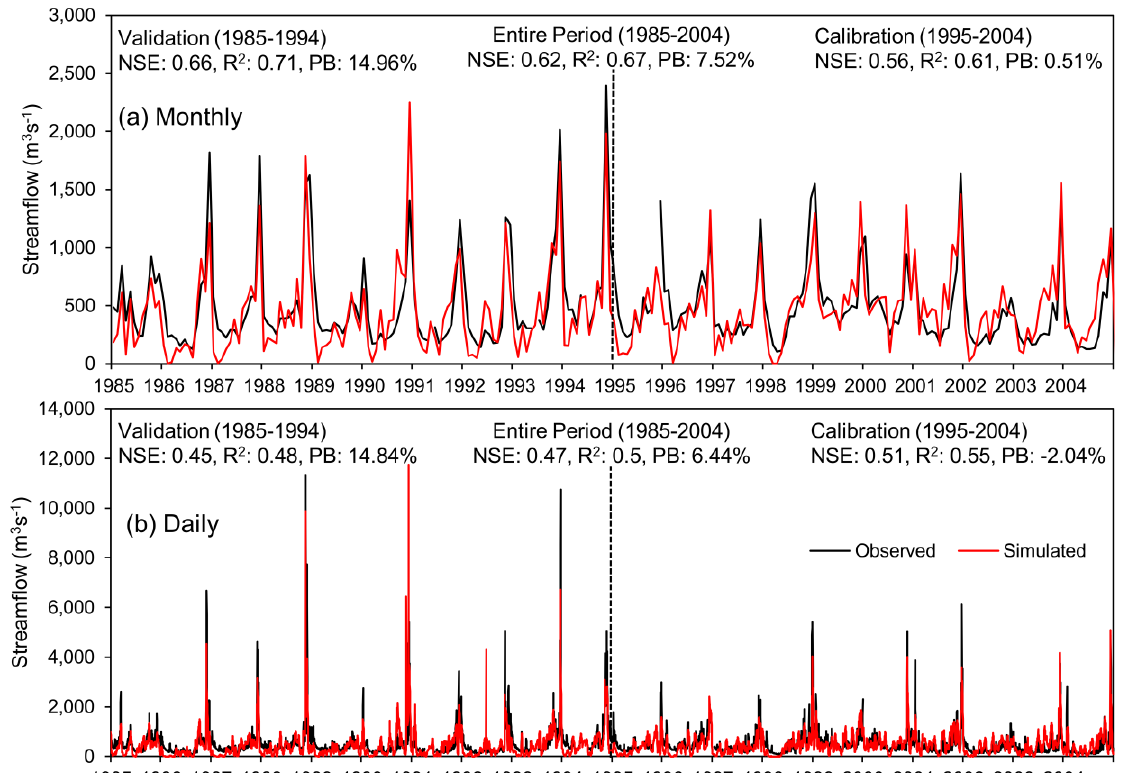
Figure 8. Observed and simulated flows at the Jambatan Guillermard in the Kelantan River Basin for both ( a ) monthly and ( b ) daily timescales.